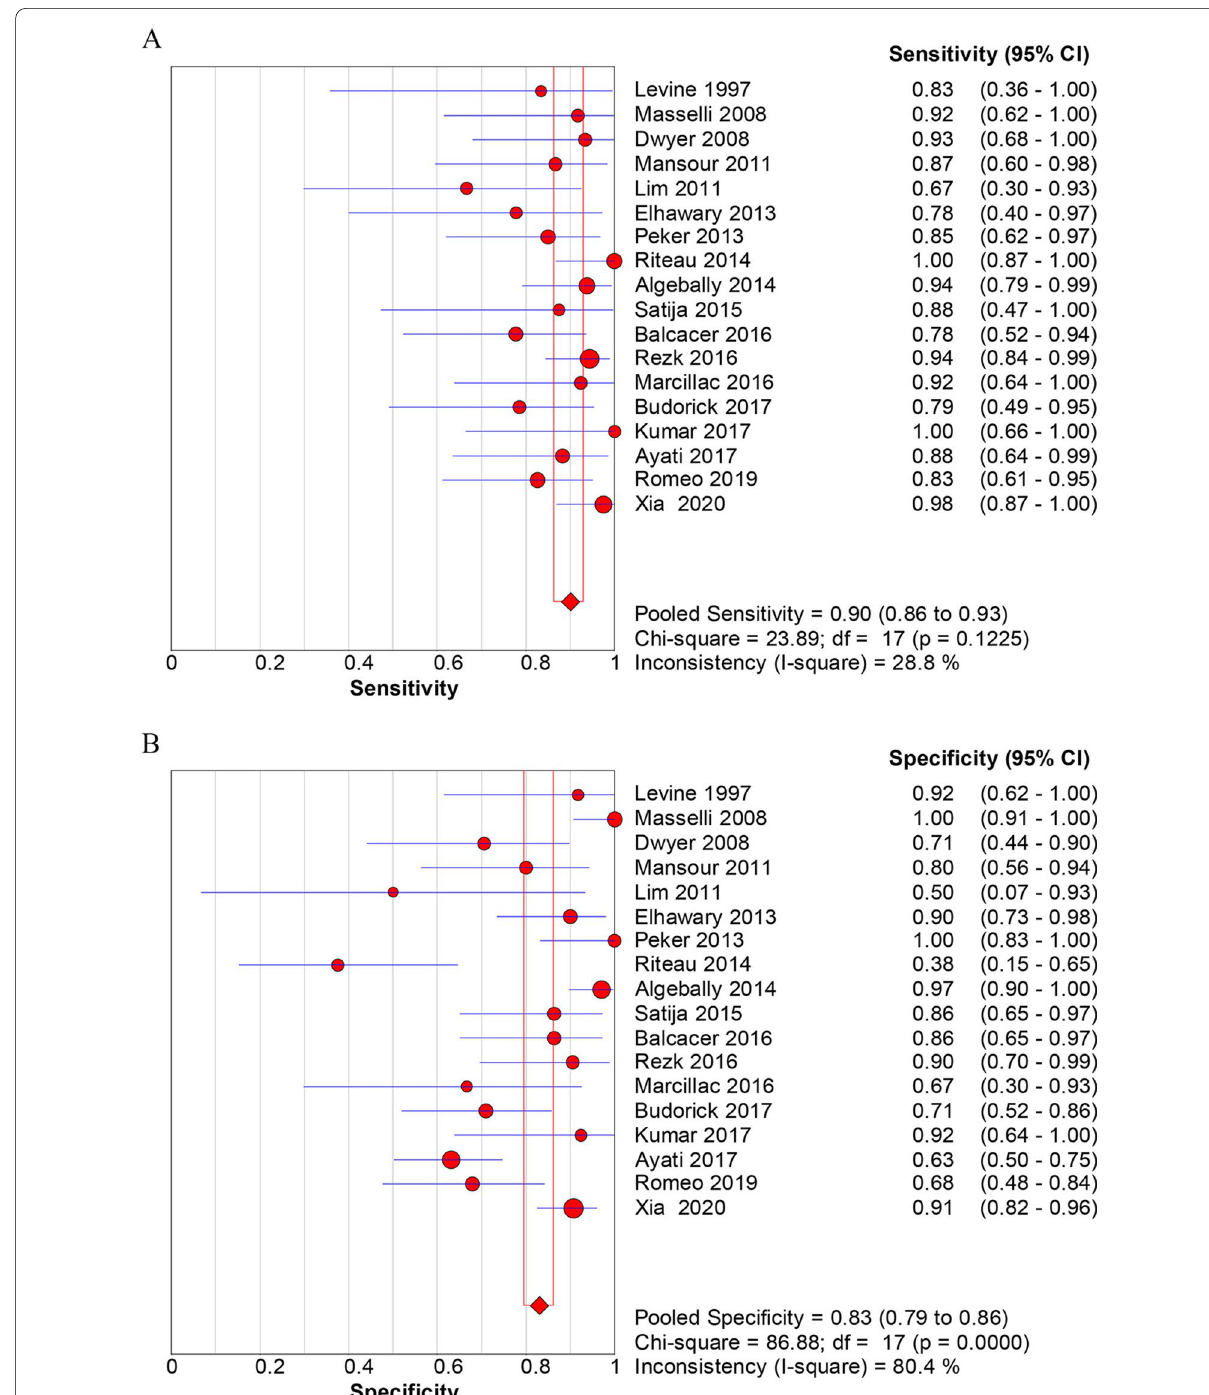
Fig. 3 Forest plots of the overall sensitivity ( A ) and specificity ( B ) of diagnosis of placenta accrete spectrum disorder (PAS) with ultrasonography (US). The first author’s name of each study is listed. CI, confidence